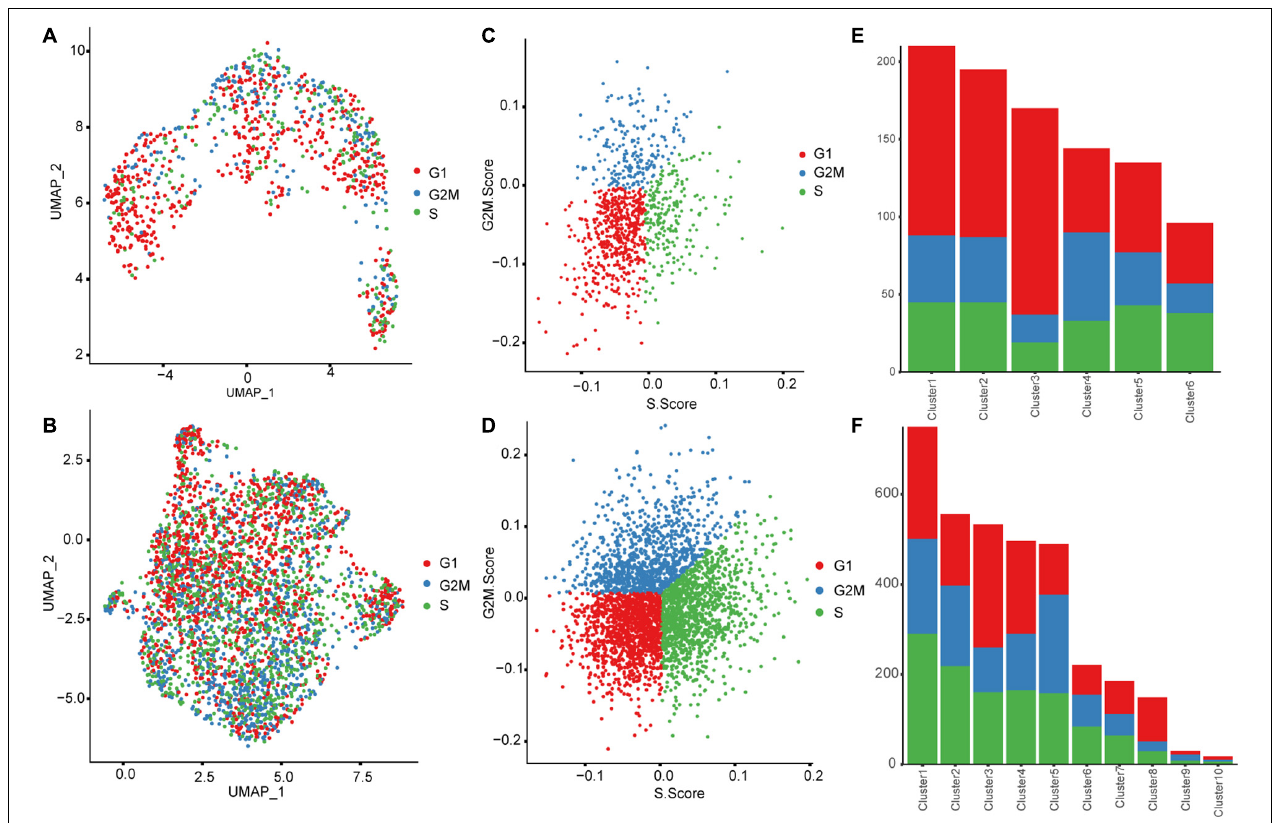
FIGURE 8 | Cell cycling stage analysis of the fetal liver cells. (A–D) UMAP plots and Cell Cycle Scoring Plot showing the cell cycle phases of in 8 PCW (A,C) and 17 PCW liver cells (B,D) . (E,F) Plot showing the proportional contribution of cells in different phases (G1, G2/M, and S) identified in each cell cluster from 8 PCW (E) and 17 PCW liver (F)